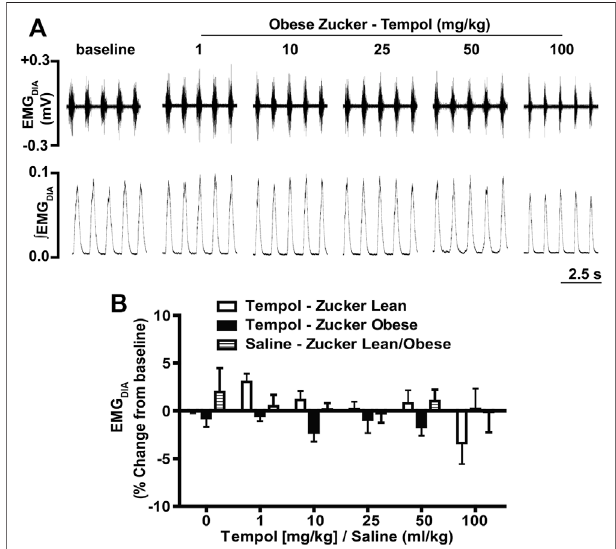
FIGURE 2 | Tempol had no effects on diaphragm muscle activity (EMG DIA ) inobeseand leanZuckerrats. (PanelA) :Representativerecordings of raw and integrated EMG DIA activity in an iso fl urane-anesthetized spontaneously breathing obese Zucker rat treated with Tempol (1 – 100 mg/kg). (Panel B) : Percentage change in EMG DIA total amplitude during administration of Tempol (1 – 100 mg/kg) in obese ( fi lled bars), lean (open bars) and saline-treated (shaded bars) Zucker rats. Repeated administration of saline (time control) had no effects on total amplitude of EMG DIAG in obese and lean Zucker rats. The values are presented as mean ± SEM. There were six obese Zucker rats and six lean Zucker rats that received Tempol and four lean/obese that received saline as a time control. Tempol did not elicit signi fi cant responses in EMG DIA in obese and lean Zucker rats (two- way ANOVA with Sidak multiple comparison